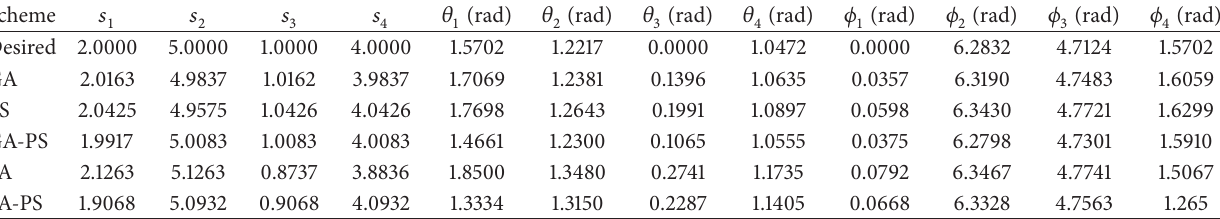
Table 9: Performance of 1-L-type array for sources located on reference axis [15].